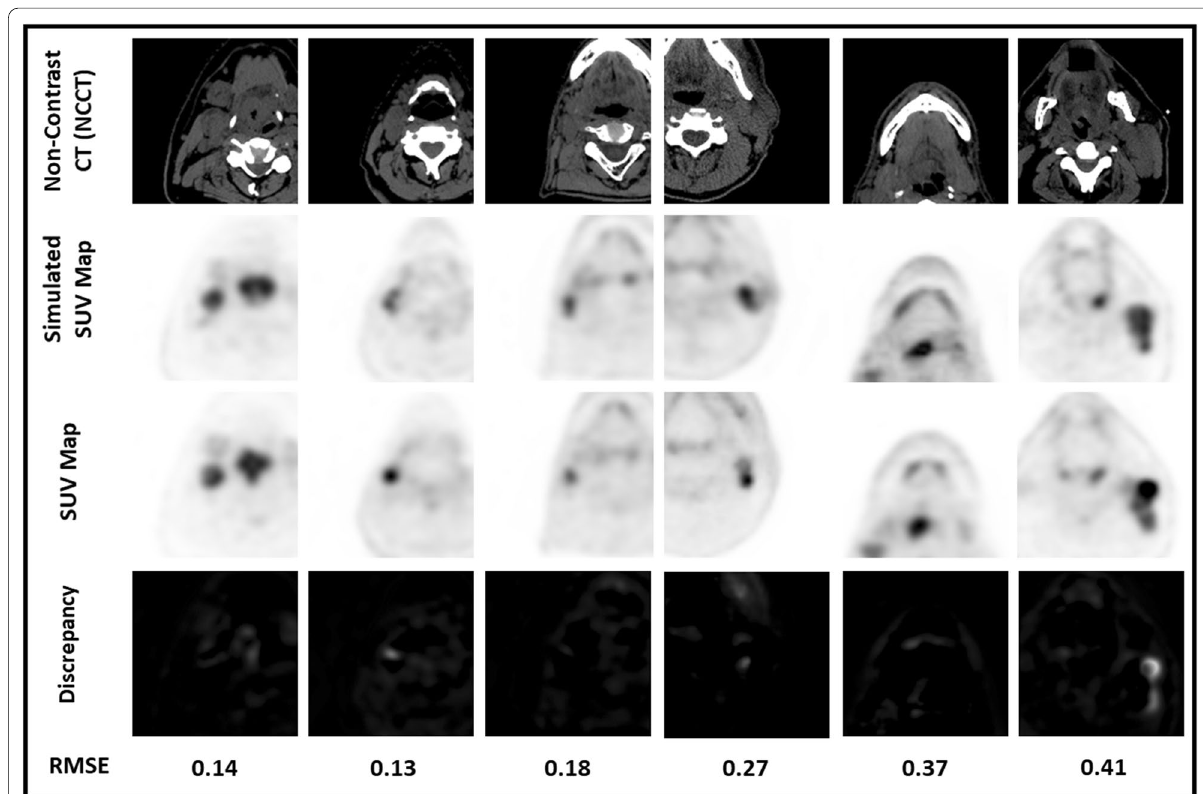
Fig. 3 Simulated SUV Map (Output of Cycle-GAN) displayed alongside its ground truth (Real SUV Map) and Non-Contrast CT axial slice for six patients. The error between the SUV maps is visualised and is represented by the RMSE. It is important to note that these SUV maps are inverted as this is the view commonly used by